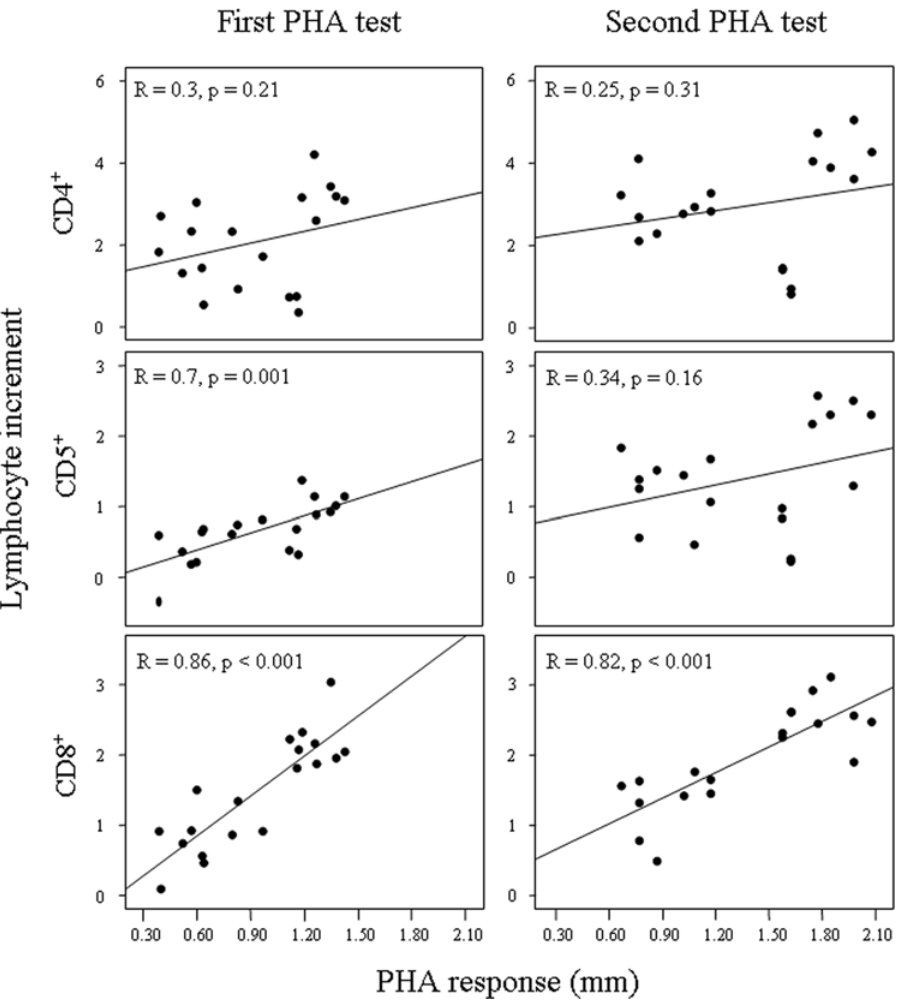
Figure 3. Relationships between local tissue swelling induced by first and second PHA injections and the concomitant changes in circulating lymphocyte subsets. Regression coefficients and statistical significance are shown for each case.